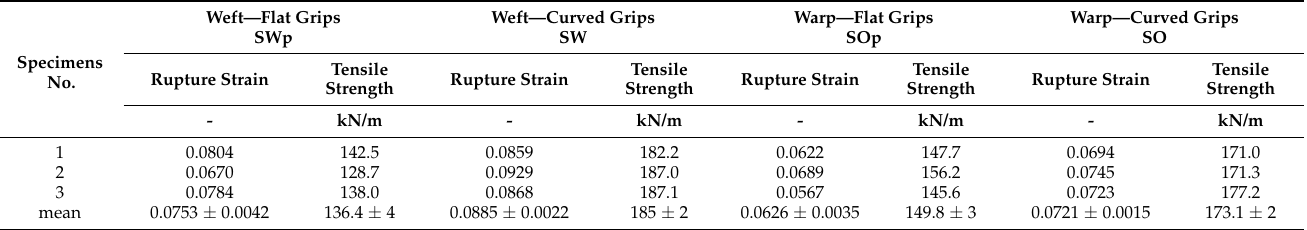
Table A1. Elongation at break and tensile strength—base specimens S-type fabric.